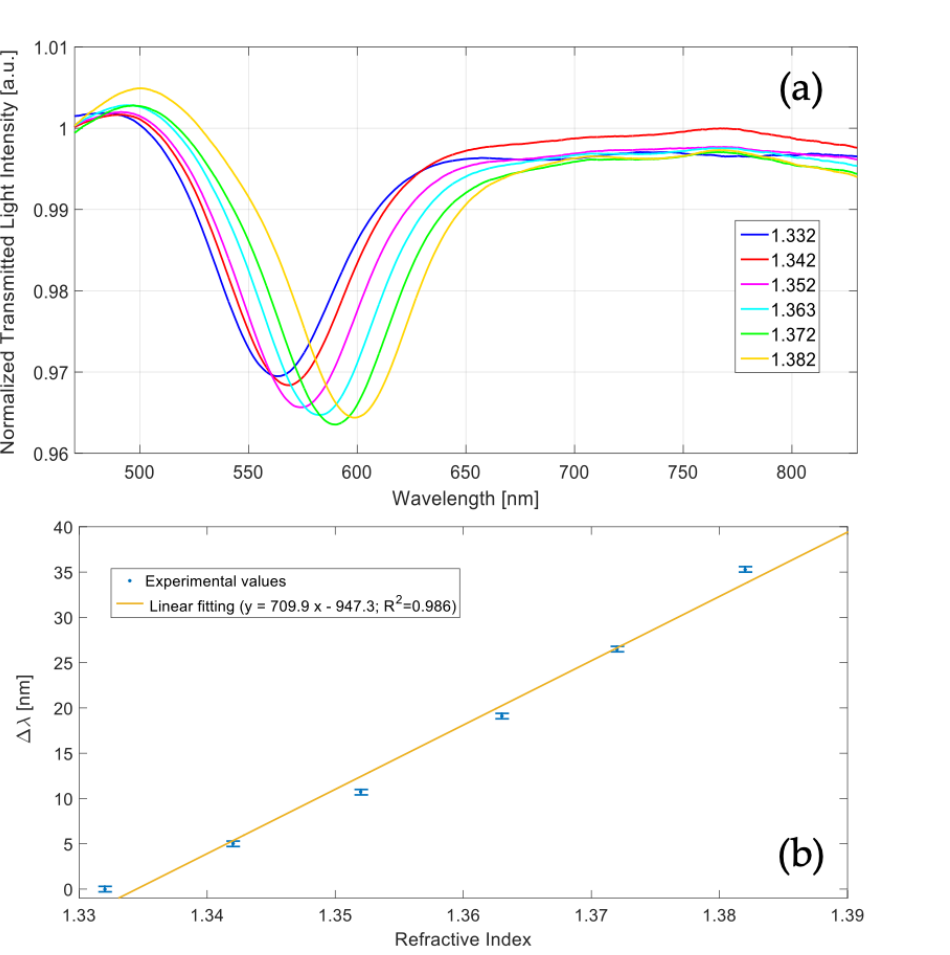
Figure 15. ( a ) Surface plasmon resonance (SPR) transmitted spectra obtained at different refractive indices. ( b ) SPR wavelength variations with respect water ( n = 1.332) along with linear fitting of the experimental data and error